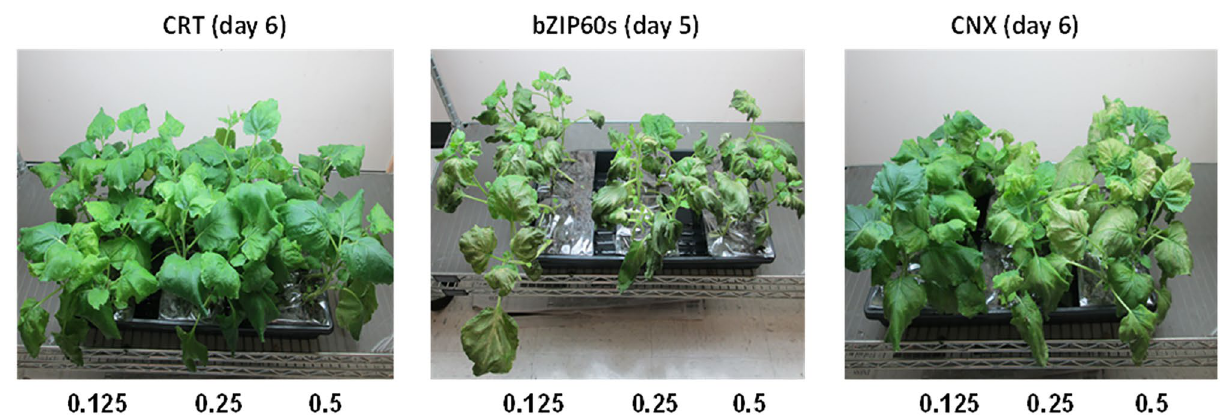
Figure 3. Assessment of toxicity of the plant master regulator bZIP60-s and the CRT and CNX chaperones in N. benthamiana leaves. Infiltrations were performed at different chaperone OD600 as